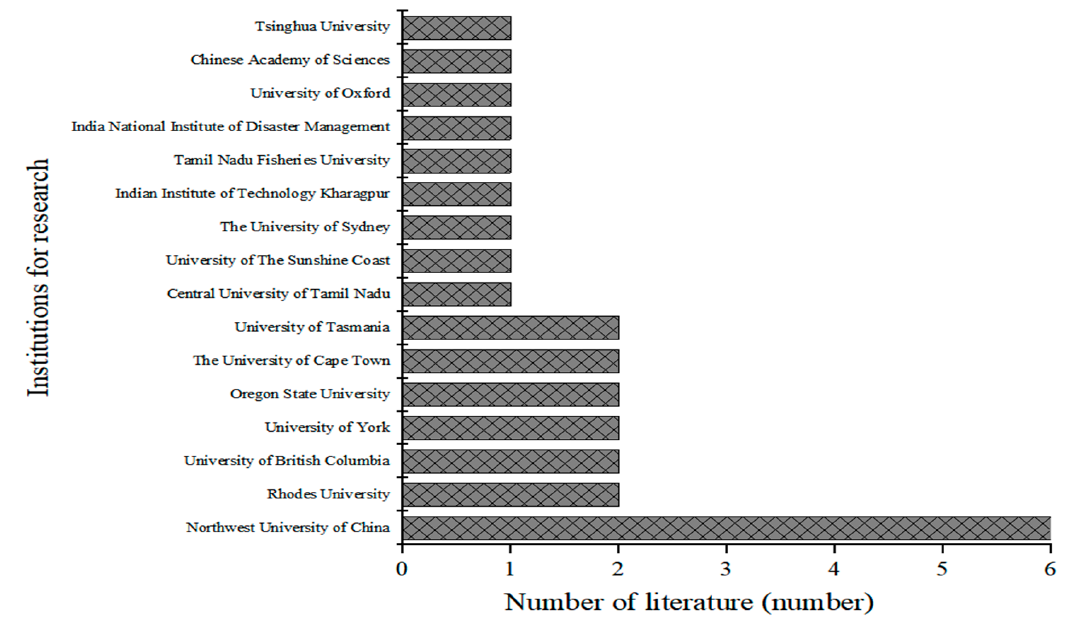
Figure 4. Literature by institution.